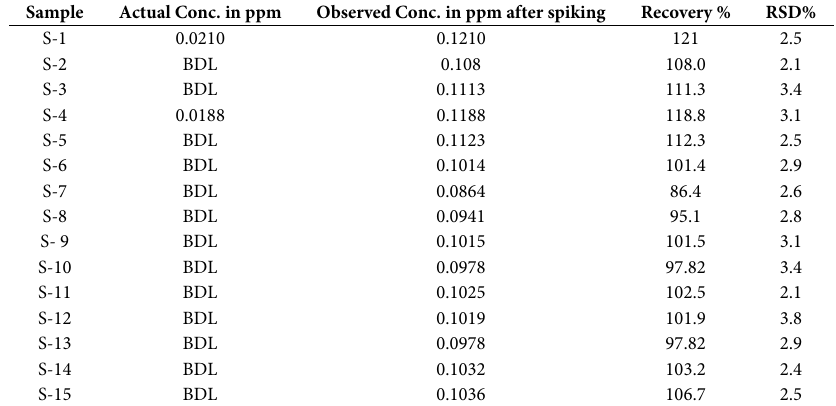
Table 3. Analytical data for Hg 2+ determination in real samples. (With and without spiking. For spiking all samples were spiked with 0.1 ppm Hg 2+